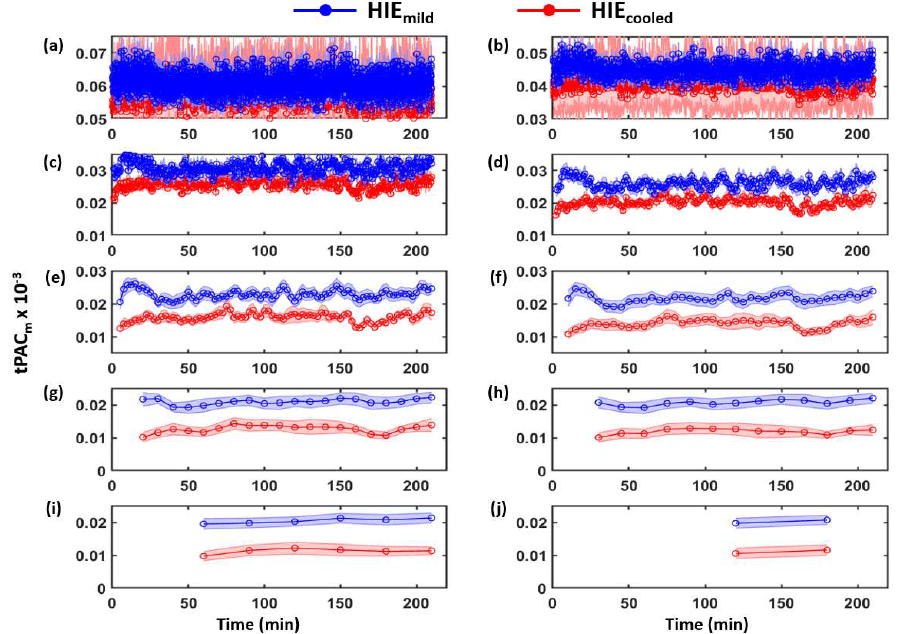
between the two groups was observed as the window size increased.